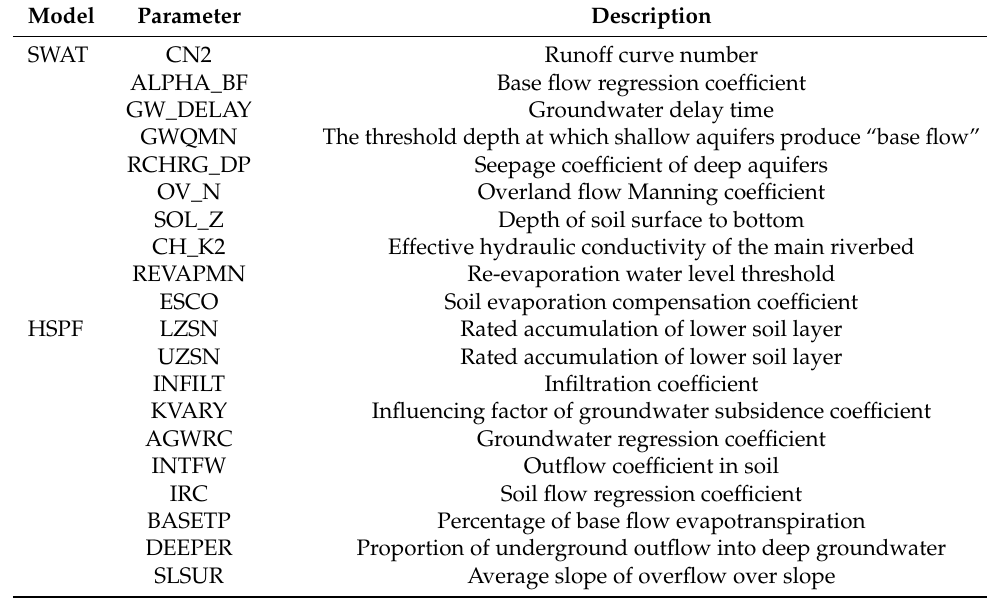
Table 2. Descriptions of parameters used in the SWAT and HSPF models.